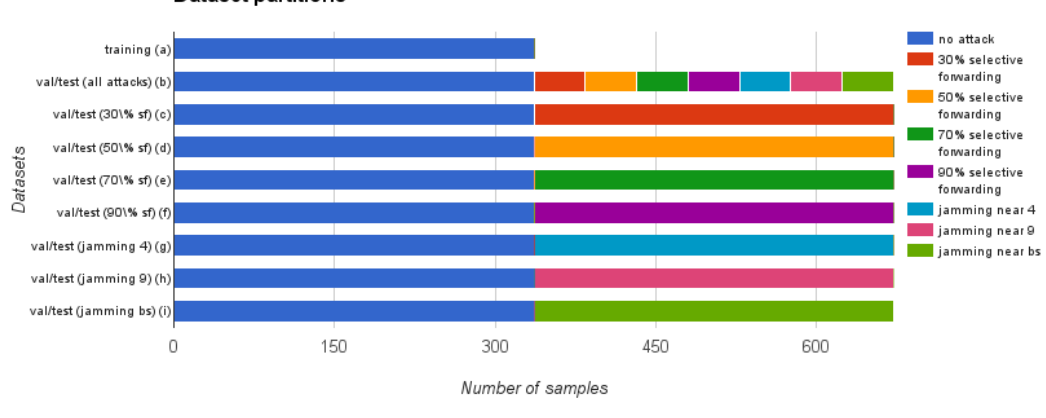
Figure 3. Size of the dataset partitions. The validation and test (val/test) datasets are partitioned in the same manner and contain the same number of samples of each attack